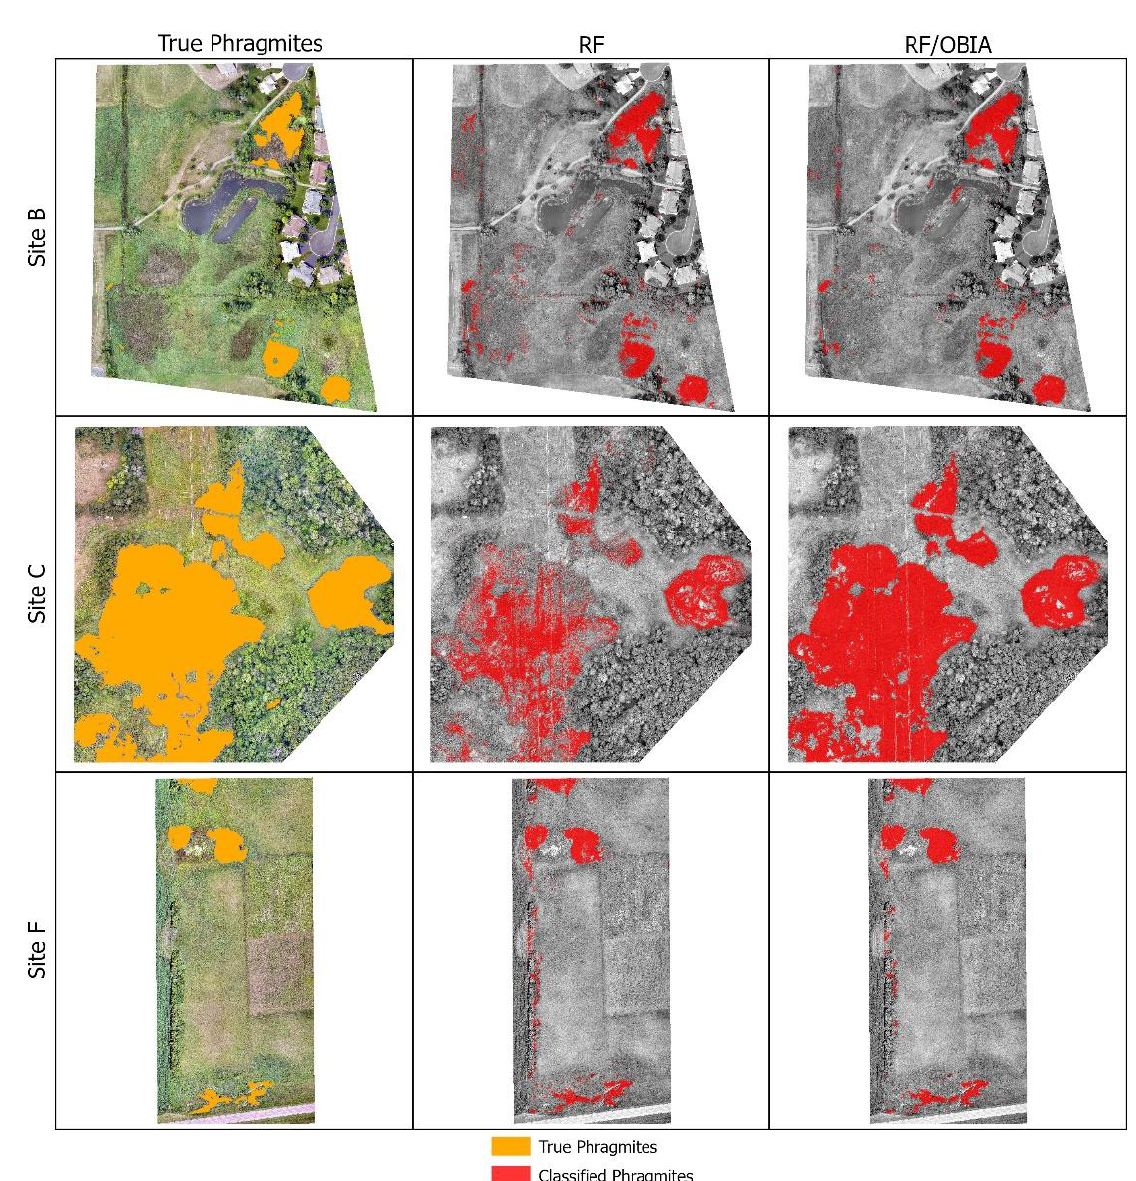
Figure 10. Classification of Phragmites (red) using a random forest with and without the post-ML OBIA rule set at the three validation sites: Delano City Park (B), Chisago City property (C), and the Swan Lake Wildlife Management Area (F). Everything not identified as Phragmites was classified as Not Phragmites . The true Phragmites location is provided as a reference (orange). Table 14. Validation assessment points for each of the three validation sites for the random forest classification without the post-ML OBIA rule set.